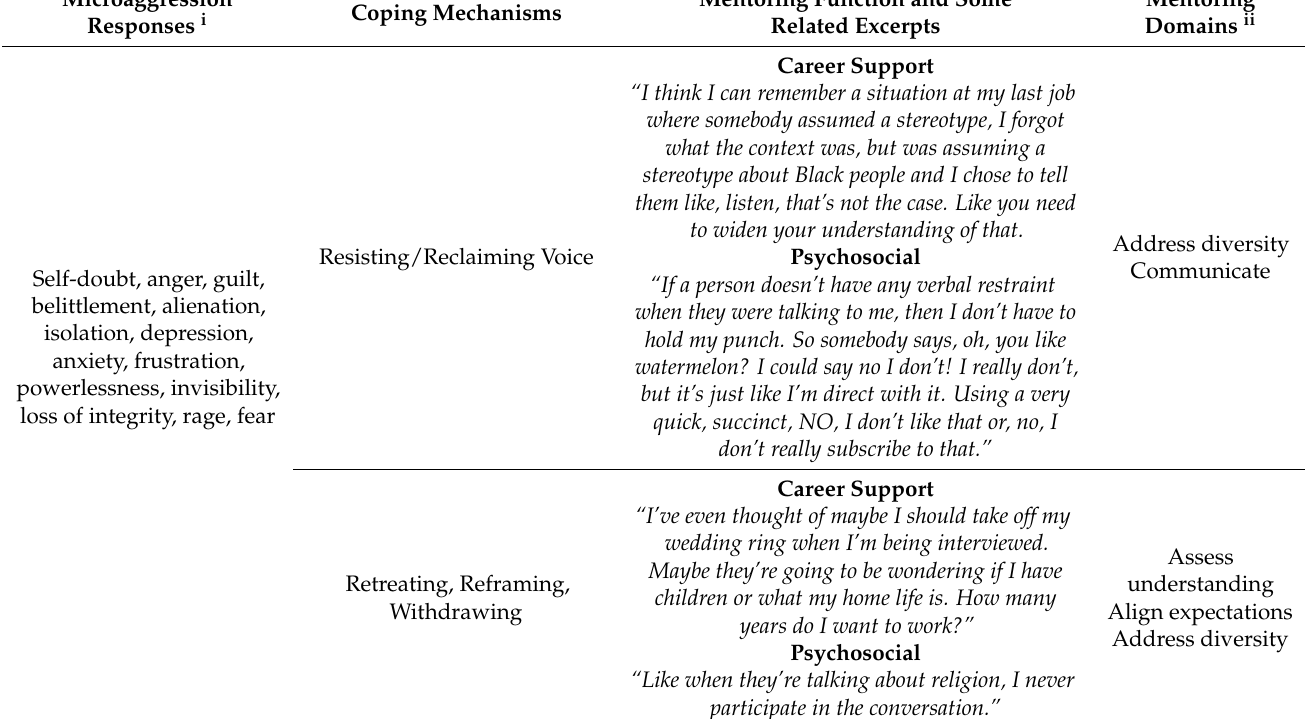
Table 1. Linkages between microaggression responses, coping mechanisms, and mentoring functions and domains. Microaggression Coping Responses i